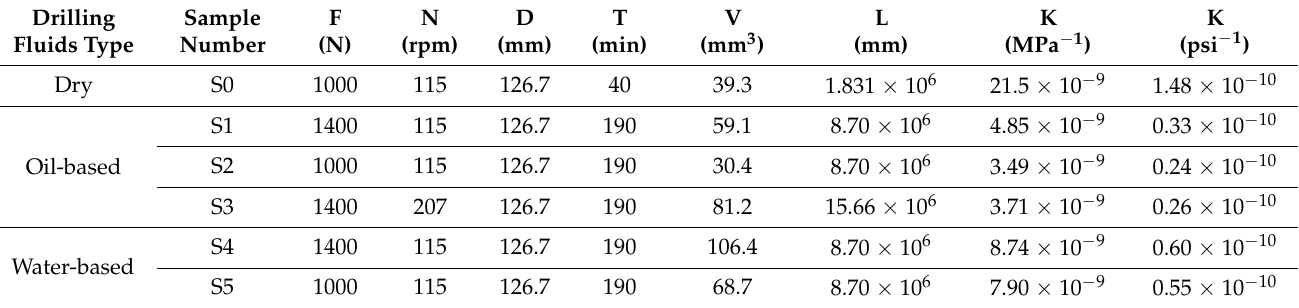
Table 3. The casing wear factor (K) of P110 samples tested under different